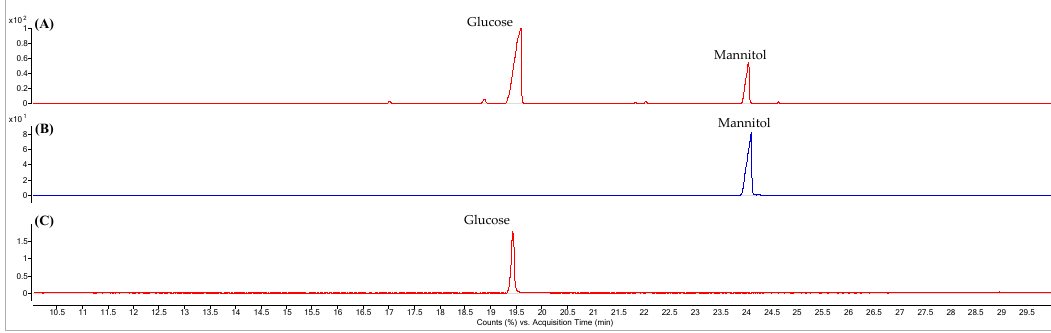
* ** Figure 7. Comparison of proliferative activities on Caco ‐ 2 (non ‐ proliferative) and HCT ‐ 116 (proliferative) cell lines of RSLDE OUT (containing 1.1 mg mL − 1 of mannitol) and the mannitol concentrations at 1 and 1.2 mg mL − 1 after 24 ( A ) and 48 h ( B ) exposure (* p < 0.05, ** p < 0.01). 4. Discussion Ganoderma lucidum spores are a rich source of bioactive compounds which are known to help in improving human health [20,21]. In the last decades, their possible implication for cancer prevention and treatment has stimulated a huge research activity concerning the exploitation of this part of G. lucidum for medical purposes [11,22–24]. For this reason, many extraction techniques were employed to obtain the maximum yield of bioactive compounds from G. lucidum [25]. In the present study, two strategies were compared to determine the best way to obtain an extract with antiproliferative activity against human cancer cells from G. lucidum spores (Figure 1). Hence, the sporoderm ‐ broken spores of G. lucidum were extracted with a Soxhlet apparatus in n ‐ hexane. The lipophilic fraction was analyzed via NMR and GC ‐ MS [16], while the exhausted material was further processed. In particular, it was split into two fractions, one of which was extracted by hot water extraction (HWE) and the other fraction by rapid solid ‐ liquid dynamic extraction (RSLDE) in order to compare a common with an innovative extraction technique. As it is known, this latter method exploits an extraction principle that allows the optimization of diffusion and osmosis phenomena, increasing the yield and reducing the extraction times compared to the classic extraction phenomena [26]. Using this principle, RSLDE allows to extract at room